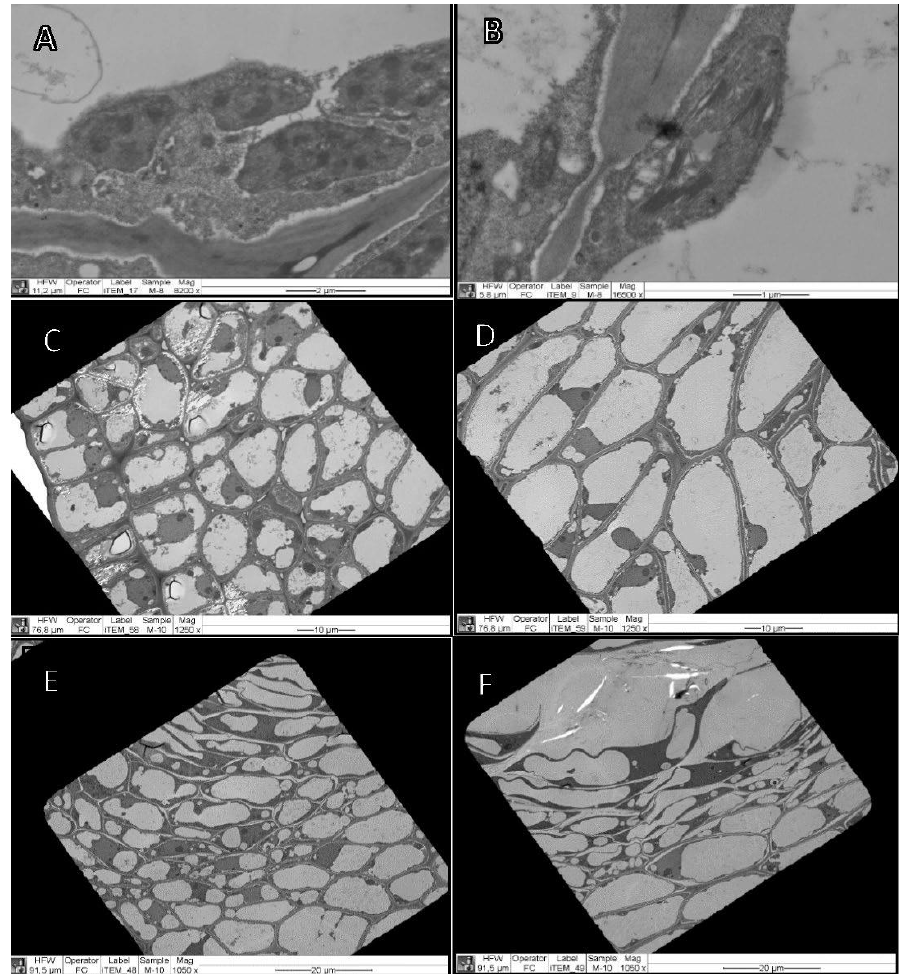
Figure 5. Transmission electron micrographs of orange fruits. Chloroplasts were found in flavedo ( A , C ) and albedo cells ( B , D ) of 30 DAFB fruits. Flavedo cells near an oil gland ( E ) and albedo cells near an oil gland ( F ) of 44 DAFB fruits.